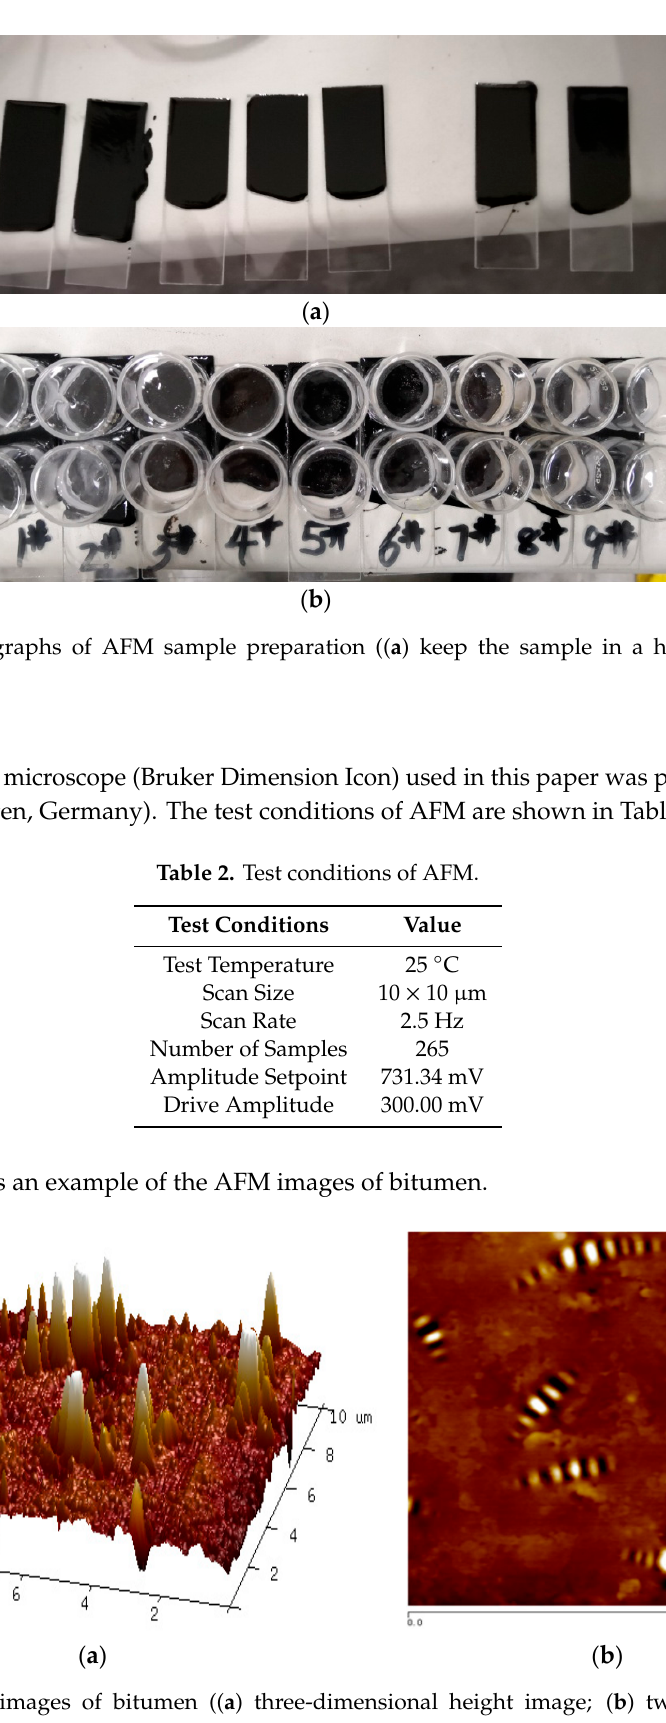
Figure 3. AFM images of bitumen (( a ) three-dimensional height image; ( b ) two-dimensional height image).